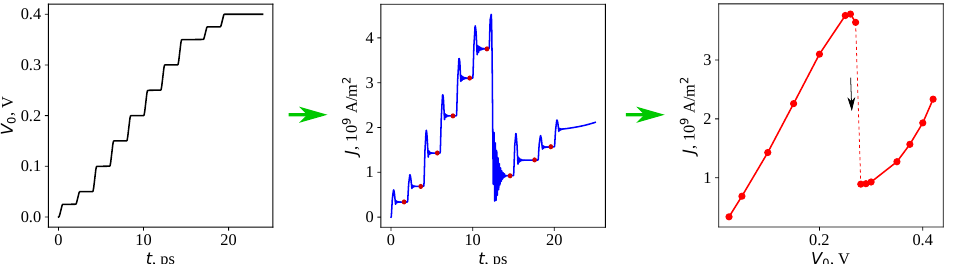
Figure 2. The scheme of calculation of the static current–voltage characteristic based on the solution of the time-dependent Schrodinger–Poisson equations. Left graph: the dependence of the applied voltage on time; central graph: the dependence of the current through the nanostructure on time; right graph: the dependence of the direct current on